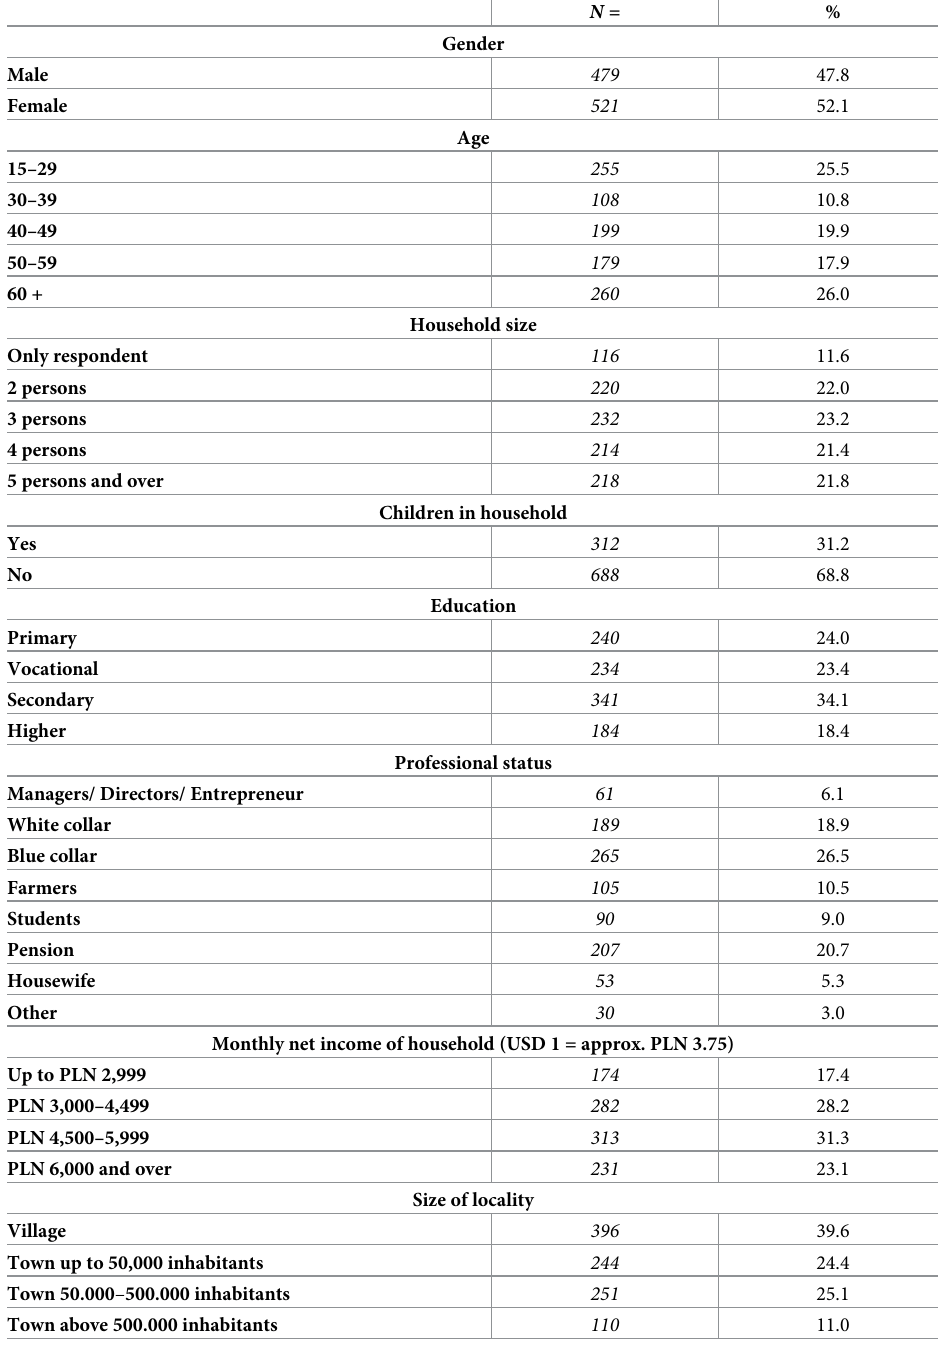
Table 1. Sociodemographic characteristics of the